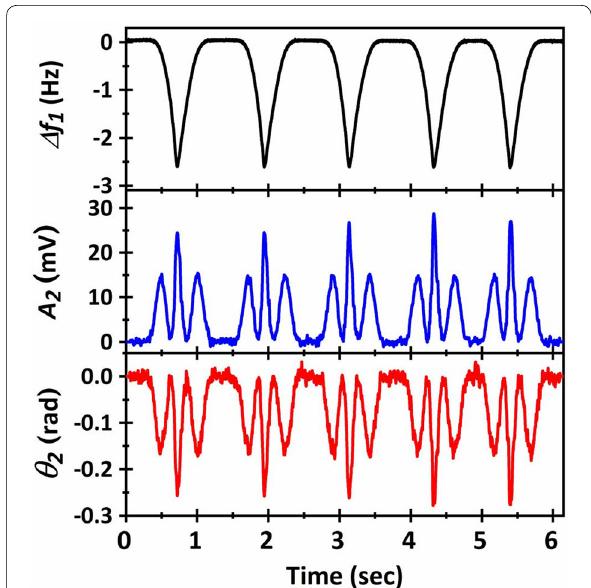
Fig. 4 Bimodal operation of a cantilever-type SMR. Resonance frequency shift of the first mode (top), amplitude (middle) and phase (bottom) changes of the second mode measured when a 5-μm diameter single polystyrene particle is dynamically trapped